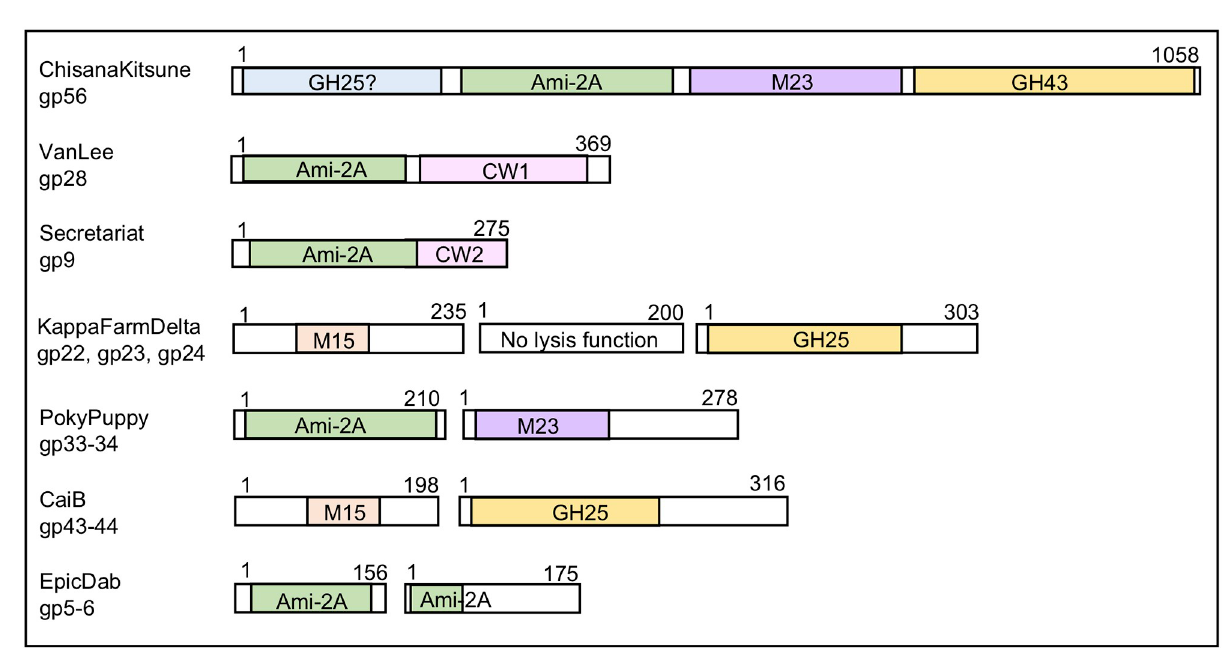
Fig 2. Organizations and modular structure of lysA genes from Gordonia phages. Based on the domains identified in each LysA (Table 3), 7 different organizations are observed in the 16 reference phages. The colored area of each LysA represents a different enzymatic domain and the size of the shading shows the coverage within each LysA. The specific activities associated with each domain are described in Table 3. Note that gp23 in KappaFarmDelta that has no evidence for lysis activity but is shown because it is located between both of the defined lysA genes (gp22 and gp24).